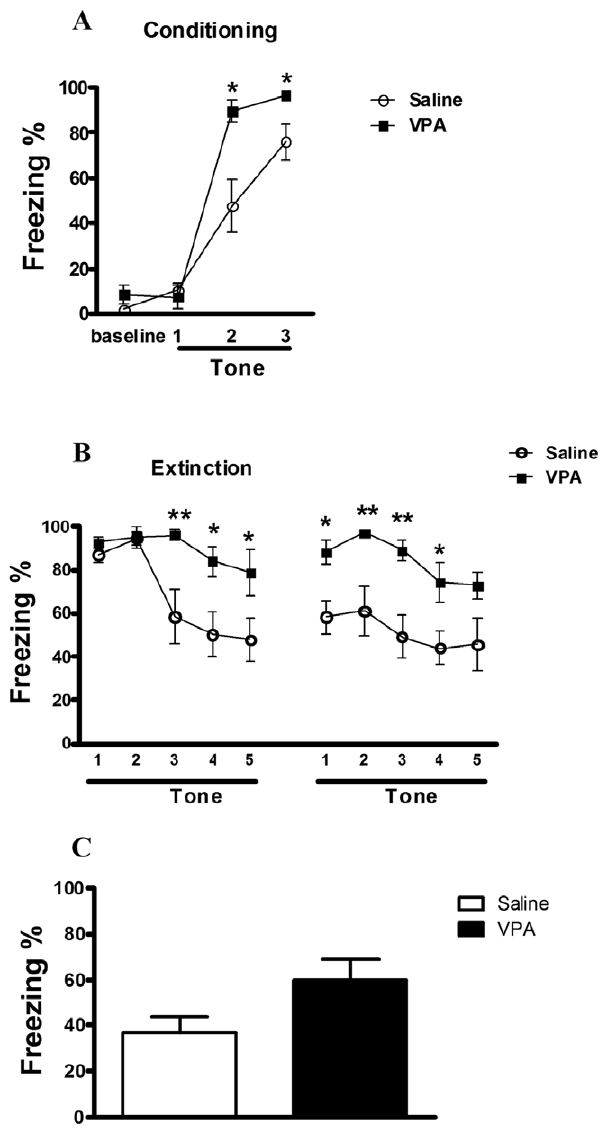
Figure 2. Impaired fear memory formation and extinction in the male VPA offspring. (A) Freezing behavior on the conditioning day. Data are the 180-s averages for the period before (baseline) and after each of the 3 tone–shock conditioning trials. (B) Freezing behavior during the extinction session, which occurred 24 h after conditioning. One block is the mean of two CS trials. (C) Freezing behavior during the 5-min contextual test. *p , 0.05, **p , 0.01 (Saline, n=11; VPA, n=10). doi:10.1371/journal.pone.0055248.g002 V curve in the presence of bicuculline (10 m M) and APV (20 m M). Consistent with the above result, the AMPA-mediated I–V curve did not differ significantly between groups [ F (4, 65) = 1.28, p = 0.29] (Figure 6B).